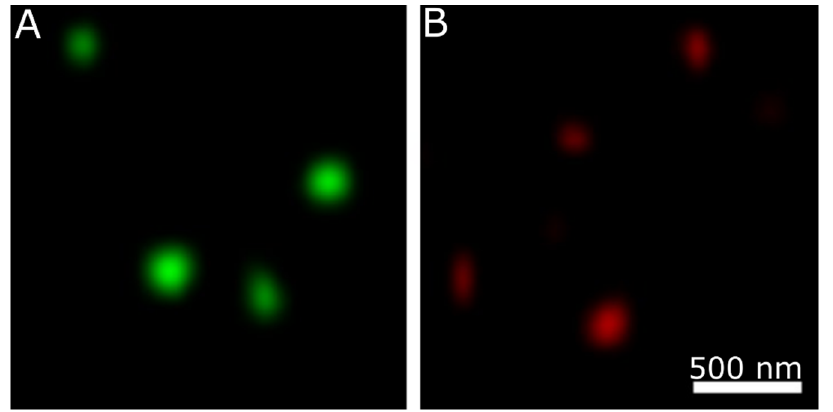
Figure 5. Fluorescence analysis of nanotubes. ( A ) Nanotube formed by 041 Δ 200GFP; ( B ) nanotube formed by 041 Δ 200mCherry. formed by 041 ∆